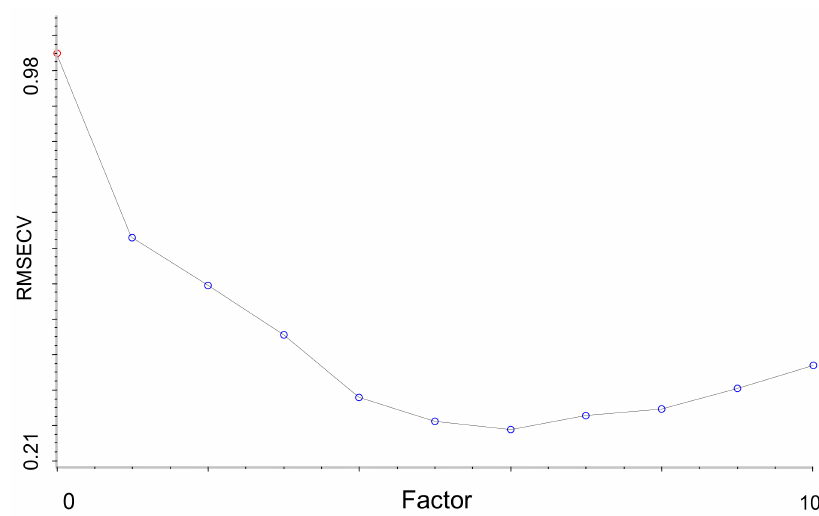
Figure 9. Plot of root mean square error of the cross validation (RMSECV) versus number of factors selected by Si-PLS for